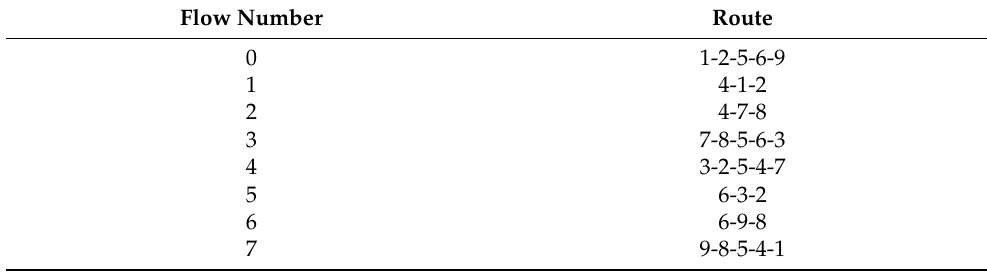
Figure 15. Topology 4 [34]. Table 9. The routes of the flow in topology